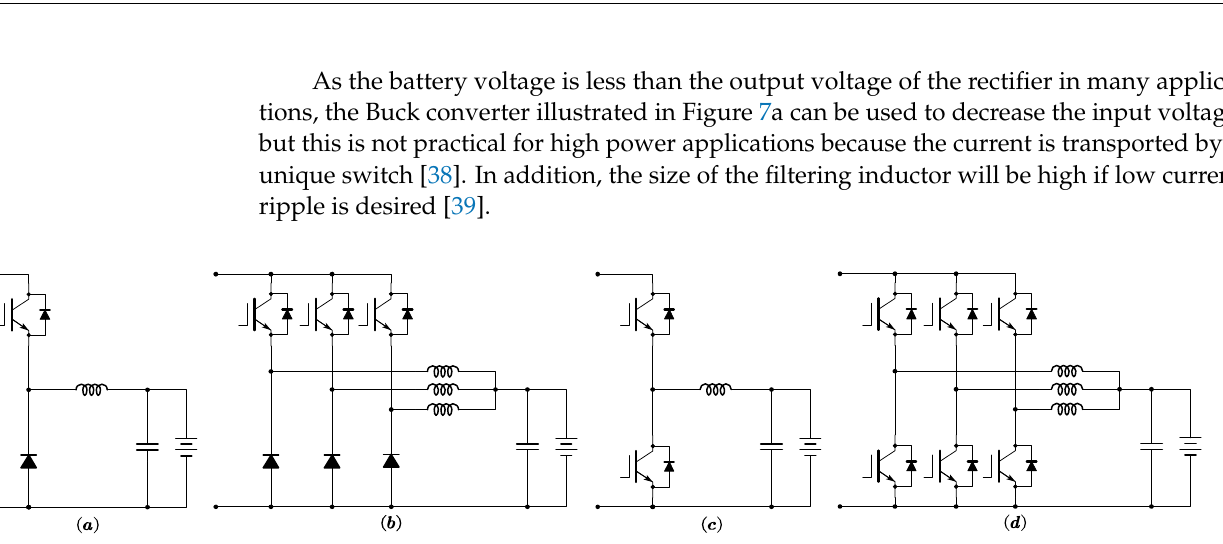
Figure 6. Three ultra-fast chargers isolated by a MV/LV transformer.